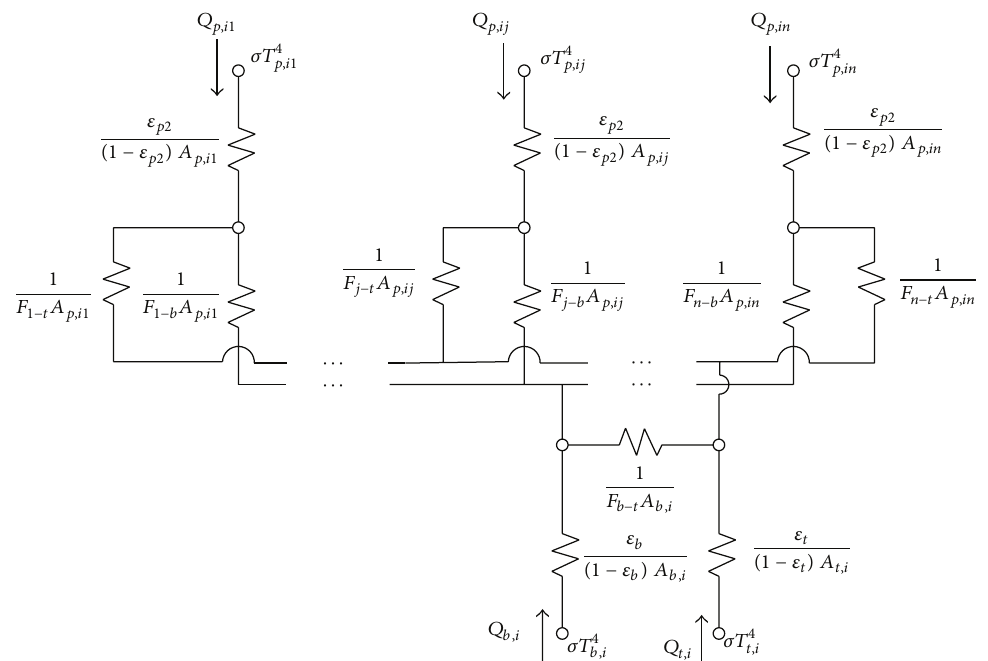
Figure 6: Irradiative heat transfer network diagram of the grid nodes.